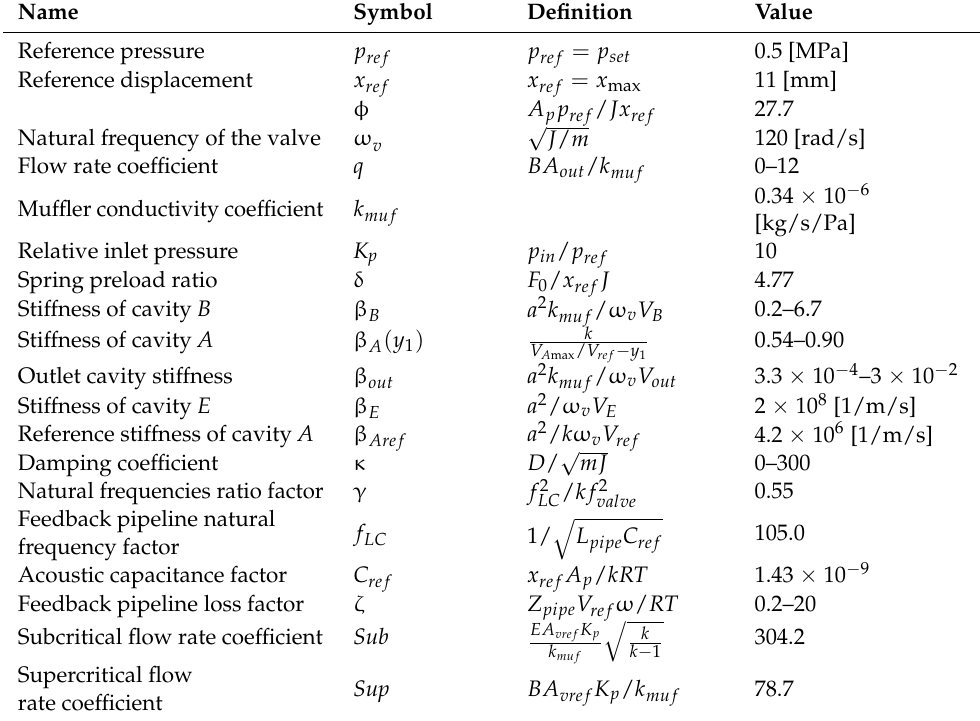
Table 1. Parameters of the studied